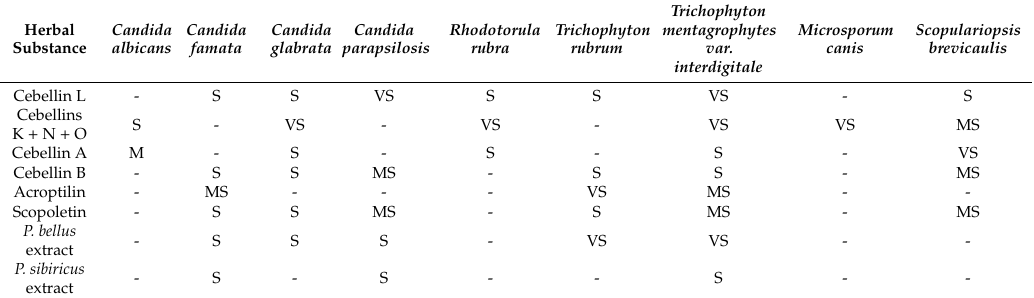
Table 2. The assessment of fungi susceptibility to studied natural compounds.